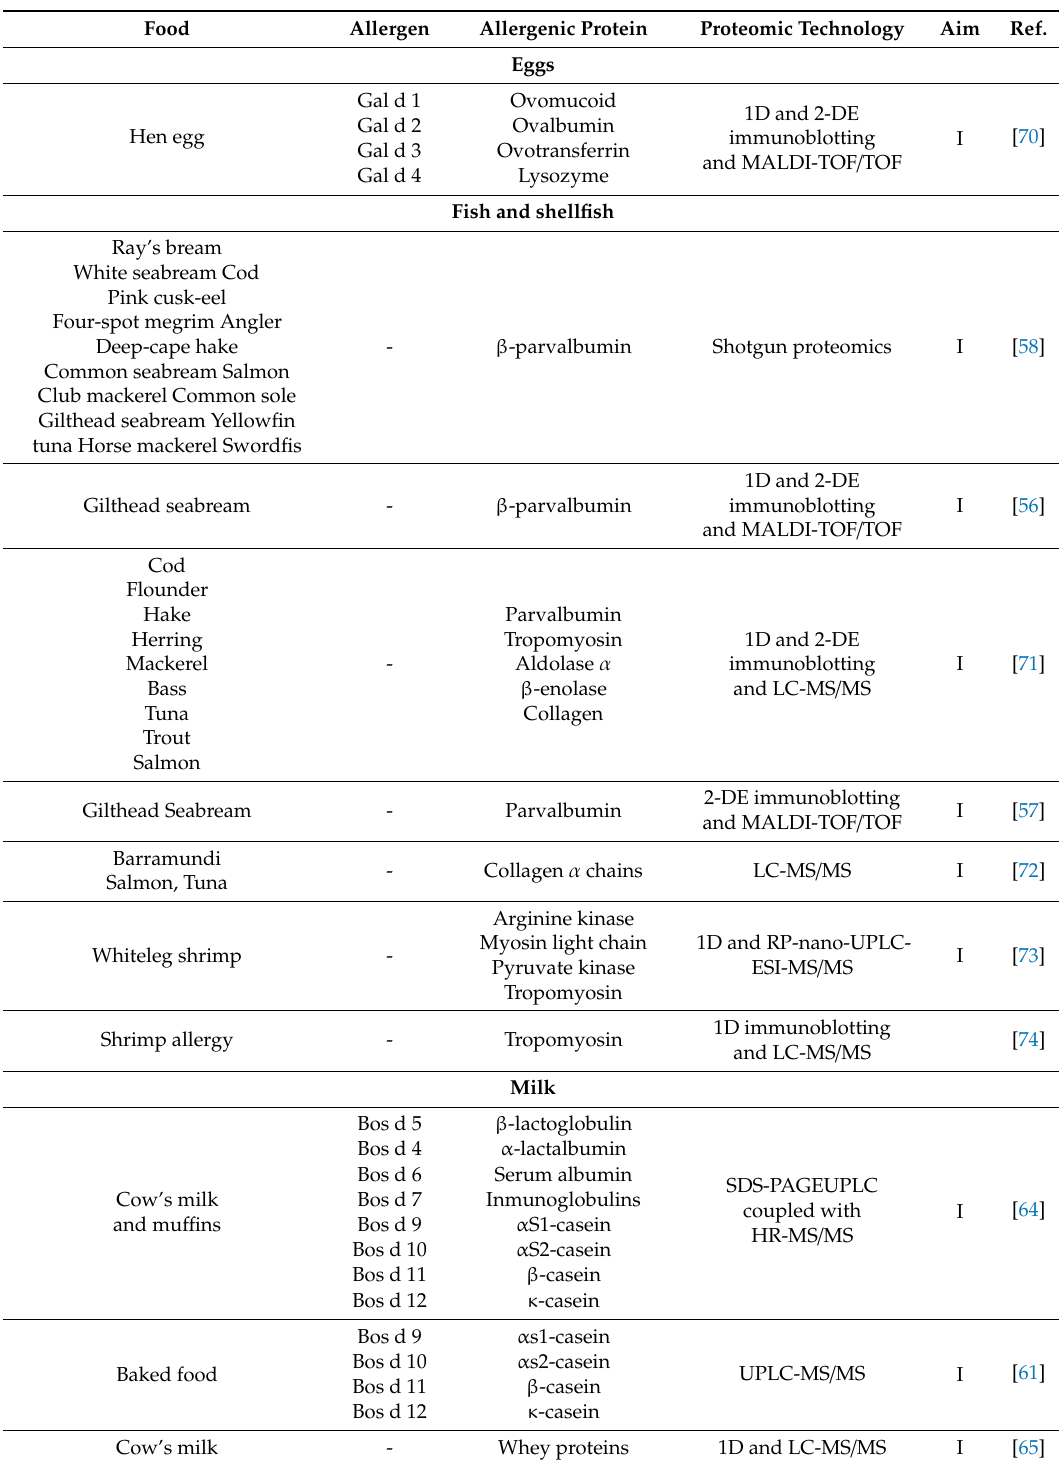
Table 2. A non-exhaustive list of current proteomics technologies for food allergen detection and quantification in animal